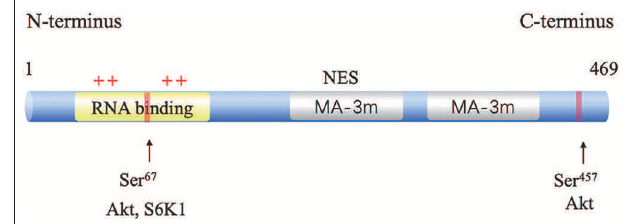
FIGURE 1 | Structure and functional sites of PDCD4. The two conserved MA-3 domains are in green, the phosphorylation sites are shown in red, and the RNA-binding site in